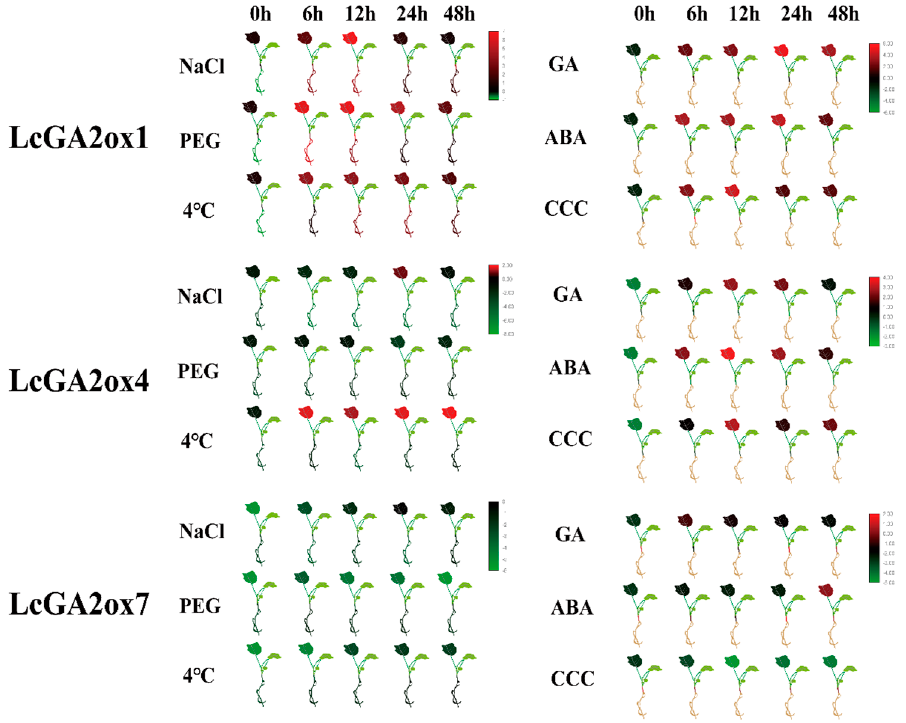
Figure 10. The gene expression level of LcGA2ox1,4, and 7 in leaves, stems, and roots under NaCl, PEG, 4 °C, ABA, GA, and CCC stress by qRT-PCR. The mean expression value was calculated from three independent biological replicates in different samples. The gene expression level was visualized by TBtools; The raw data of relative expression values and standard errors is provided in Table S4.